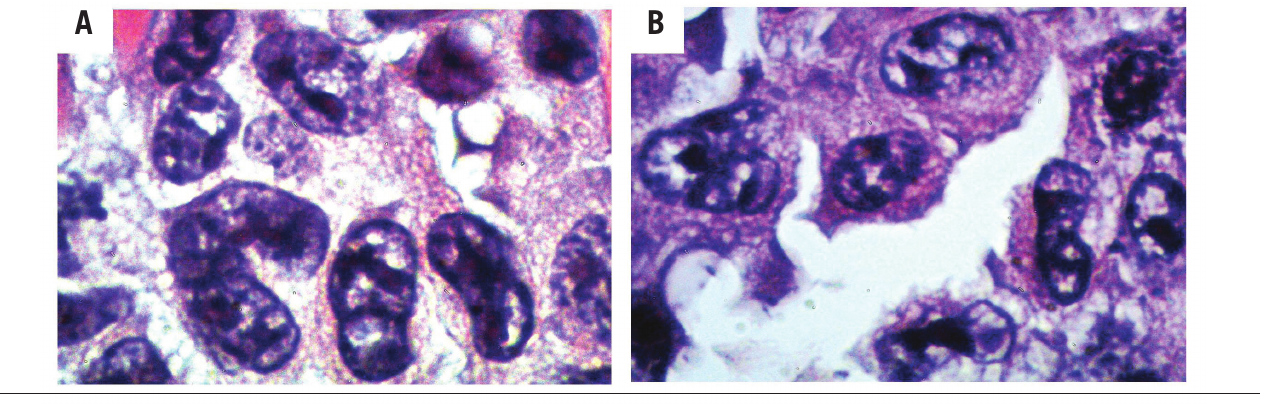
figurE 4 − Histopathological analyzes of tumor cells Histopathological analyzes of the footpads of mice inoculated with EET after 21 days, HE 1000×. A) control group; B) group B beginning of watercress ingestion prior to tumor inoculation, HE 1000×. Tumor cells showed marked pleomorphism, evident nucleoli and enlarged nuclei. EET: experimental Ehrlich tumor; HE: hematoxylin and eosin.